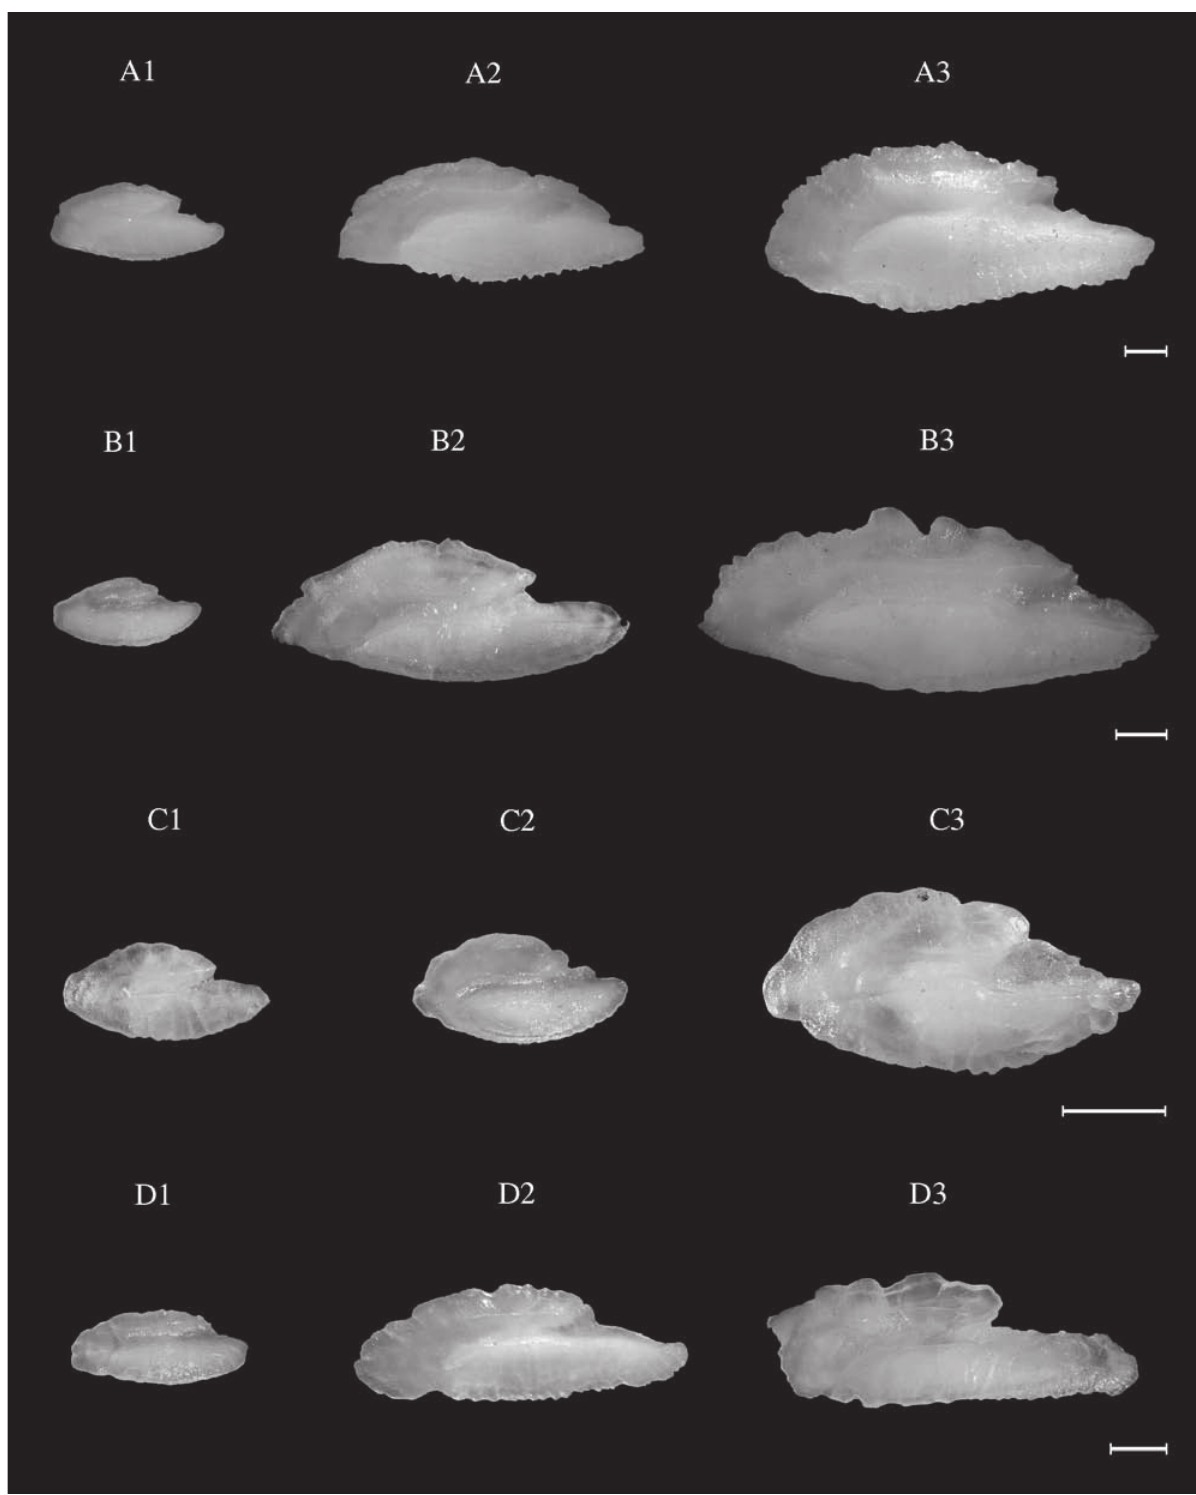
Fig. 49. – Serranus atricauda (CEA). TL: A1, 12.1 cm; A2, 25.6 cm; A3, 34.5 cm. Serranus cabrilla . TL: B1, 7.0 cm (WM); B2, 17.7 cm (NEA); B3, 25.5 cm (CEA). Serranus hepatus . TL: C1, 5.3 cm (NEA); C2, 8.0 cm (WM); C3, 13.4 cm (NEA). Serranus scriba . TL: D1, 7.0 cm (WM); D2, 17.5 cm (CEA); D3, 24.0 cm (CEA). Scale bar = 1